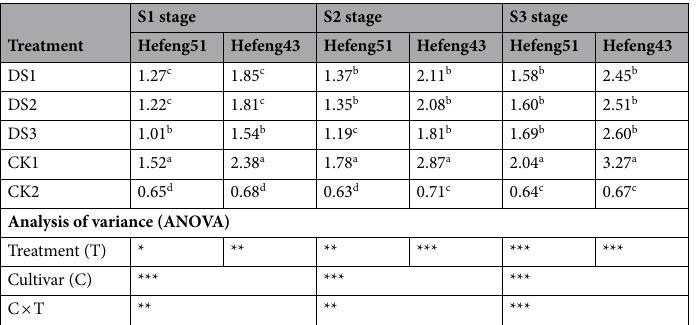
Table 7. Effects of foliar α-oxoglutarate and nitrogen on ammonium content under drought stress (µmol h −1 g −1 FW). Means with same letter within columns are not significantly different ( P < 0.05) using LSD test. ***, **, *Significance at 0.001, 0.01, and 0.05, respectively.